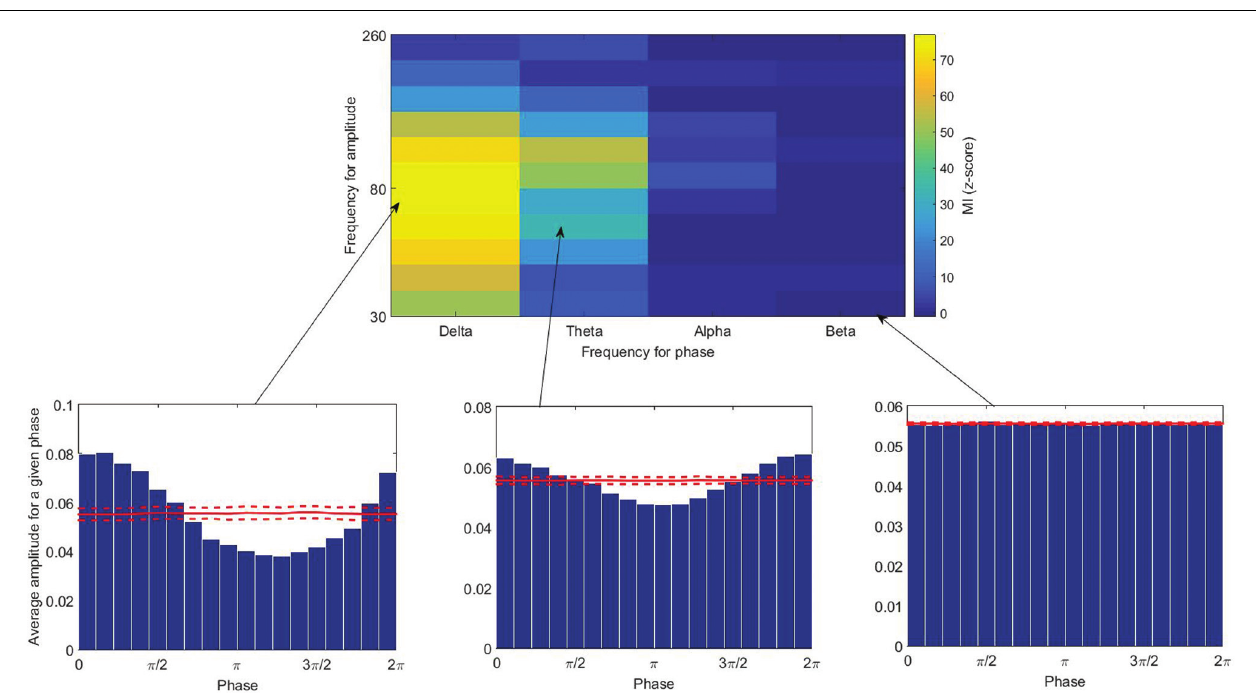
FIGURE 2 | (Top) The modulation index calculated for different pairs of low and high frequencies. (Below) Average amplitude for a given phase (from left to right: high, moderate, and low couplings). Solid and broken red lines indicate the mean and the standard deviation among the 200 surrogate